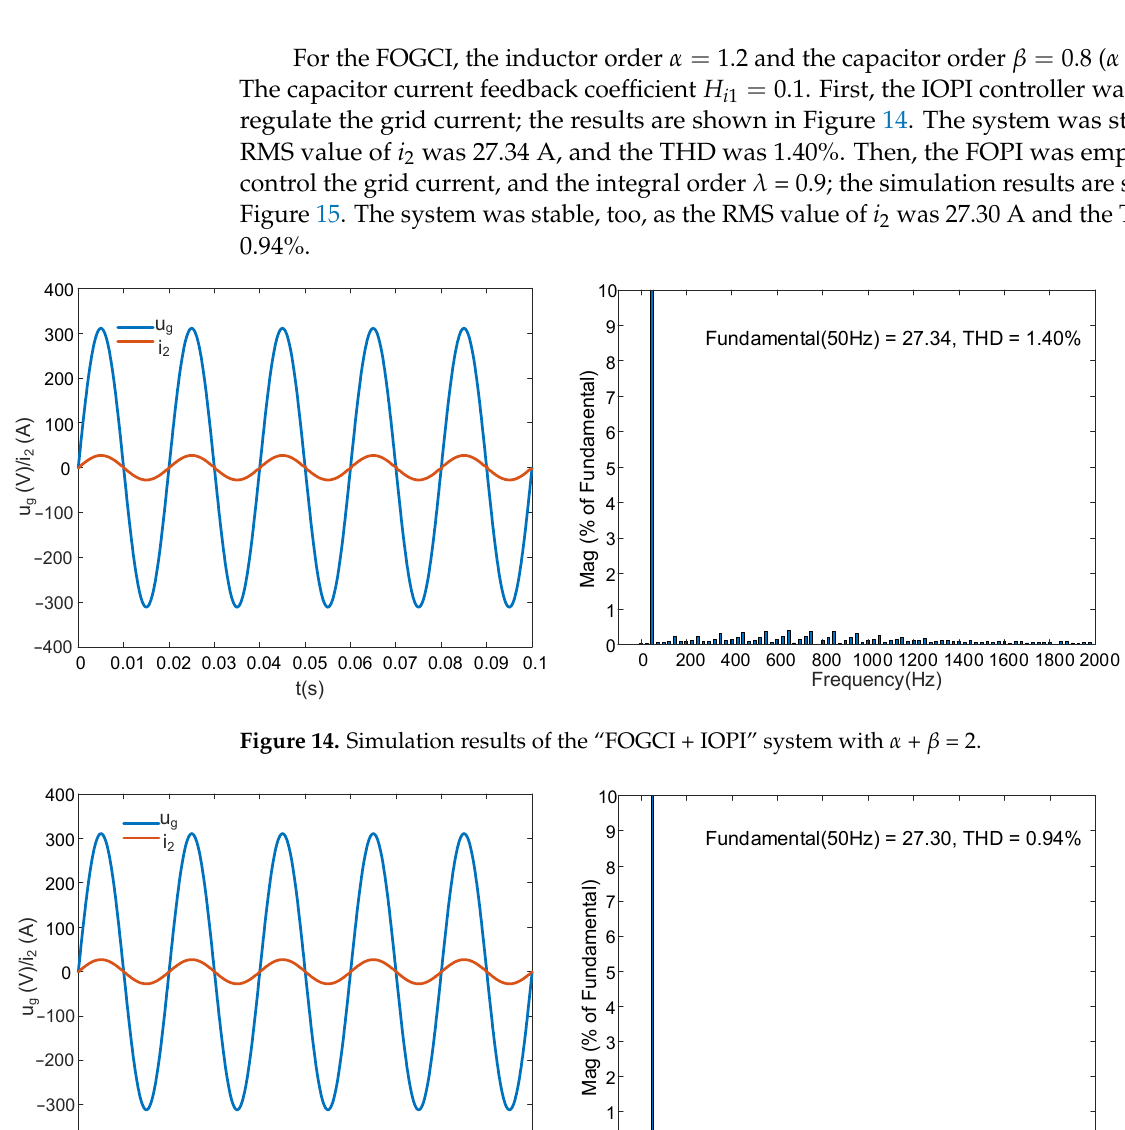
Figure 15. Simulation results of the “FOGCI + FOPI” system with α + β = 2. The simulation results showed that each system had small stable-state error and that the grid current THD of the FOGCI was lower than that of the IOGCI under both IOPI and FOPI control.